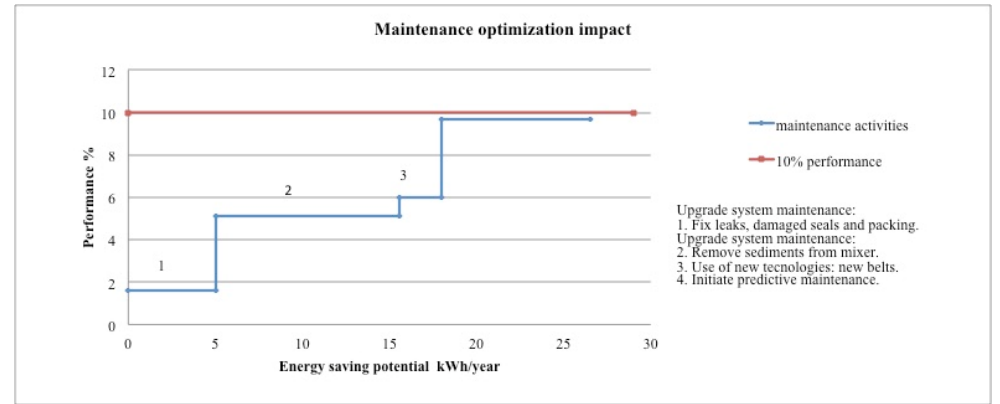
Figure 13. Maintenance optimization impact (case study).